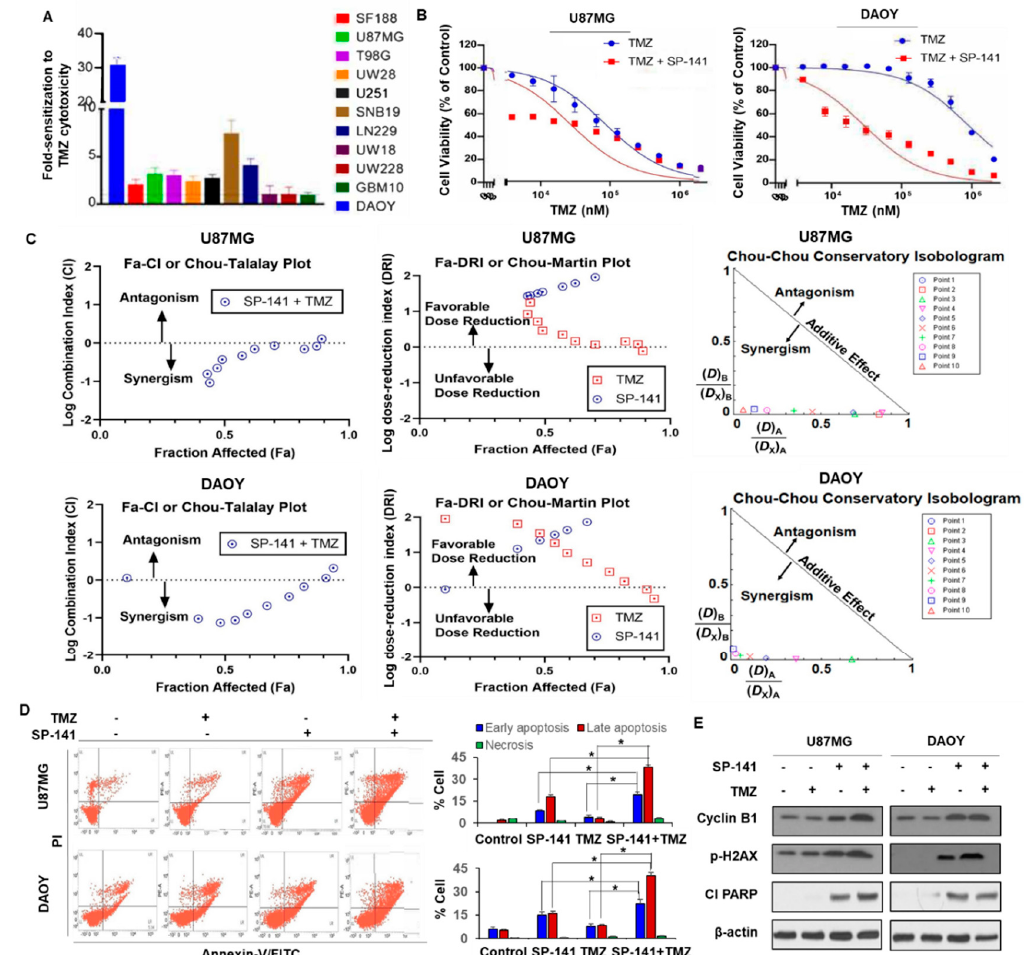
Figure 5. SP-141 sensitizes brain tumor cells to temozolomide treatment. ( A ) Bar graph showing the potentiation of TMZ cytotoxicity by SP-141 in a panel of 11 glioblastoma and medulloblastoma cell lines. The tumor cells were simultaneously exposed to SP-141 (at their respective IC 20 values) and varying concentrations of TMZ (3 µM to 2 mM). The mean IC 50 values of TMZ alone and those of the TMZ + SP-141 combinations were calculated in four independent cytotoxicity assays, each run in triplicate. The average fold-increase in cell killing (± SEM) for the TMZ + SP-141 combination was calculated and is represented in the bar graphs. ( B ) Potentiation of TMZ cytotoxicity by SP-141. The cytotoxicity of TMZ alone and in combination with SP-141 (at its IC 20 concentration) against U87MG and DAOY brain tumor cells is shown. ( C ) Analyses of synergism in the cytotoxicity of the SP-141 + TMZ combination in DAOY and U87MG cells as determined by the CompuSyn software. The combination index (CI, Chou–Talalay plots) and dose-reduction index (DRI, Chou–Martin Plots) were generated according to the levels of growth inhibition (fraction affected, FA) by each drug used individually and in combination. The normalized isobologram showed that all 10 combination data points were located in the lower left, indicating synergism. The combination index (CI) = (D)A/(Dx)A + (D)B/(Dx)B where (D)A and (D)B were the concentrations of each drug alone required to exert x% effect, while (Dx)A and (Dx)B were the concentrations of drugs in combination to elicit the same effect. ( D ) Representative Annexin-V-FITC staining of DAOY and U87MG cells treated with 0.25 µM SP-141 and 60 µM TMZ, alone and in combination for 24 h. The mean percentage of cells in early and late apoptotic stages from four experiments of Annexin-V staining are shown in the bar graph. The differences in the early and late apoptotic populations in the cells treated with TMZ + SP-141 compared with TMZ alone or SP-141 alone were statistically significant (* p < 0.01). ( E ) The cells were treated with SP-141 and TMZ for 24 h prior to analyses of the protein expression.